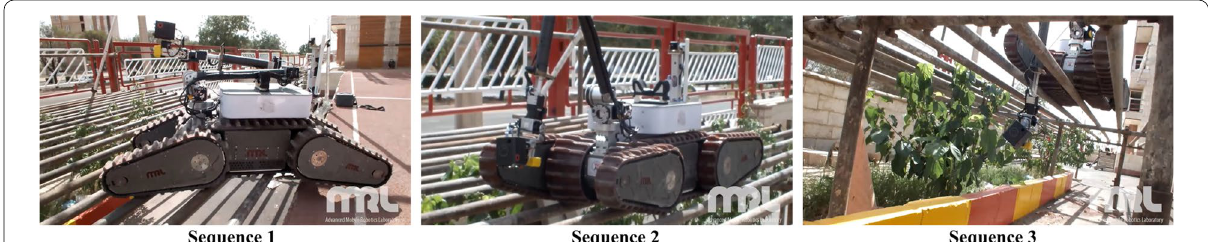
Fig. 30 The robot is inspecting areas beneath a scaffolded